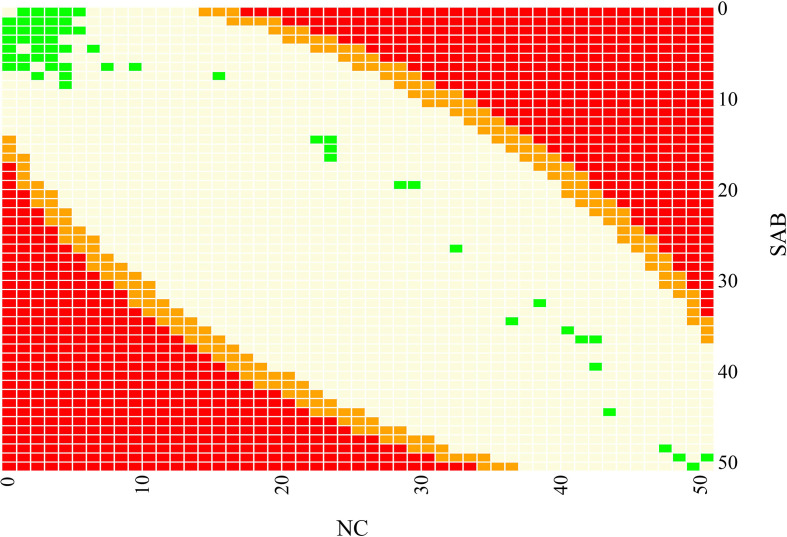
SNP significance level in comparison to SNP distribution. Each colour represents varying significance values after multiple testing correction; red represents a P value <0.05, orange represents a P value >0.05 and <1, and light yellow represents a P value=1. All 12 064 SNPs from this dataset are marked in green. This figure demonstrates that none of the SNPs identified in this study were significantly associated with either SAB or NC infection type.